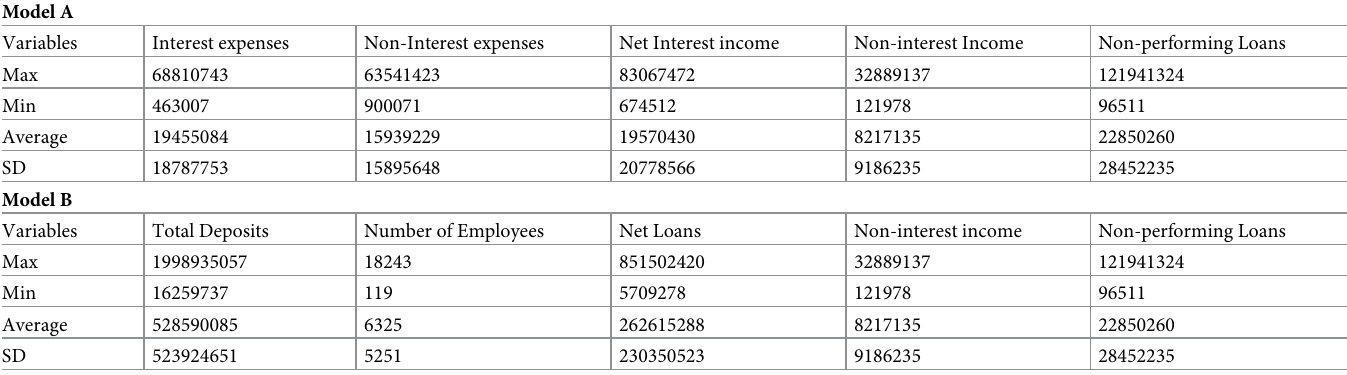
Table 3. Descriptive statistics of both